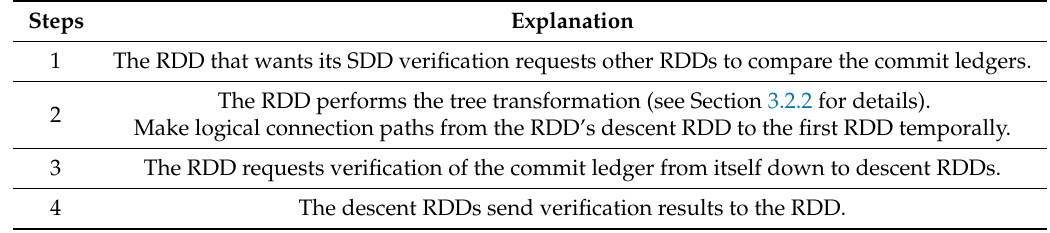
Table 4. The ledger verification algorithm using the binary tree-structured lightweight